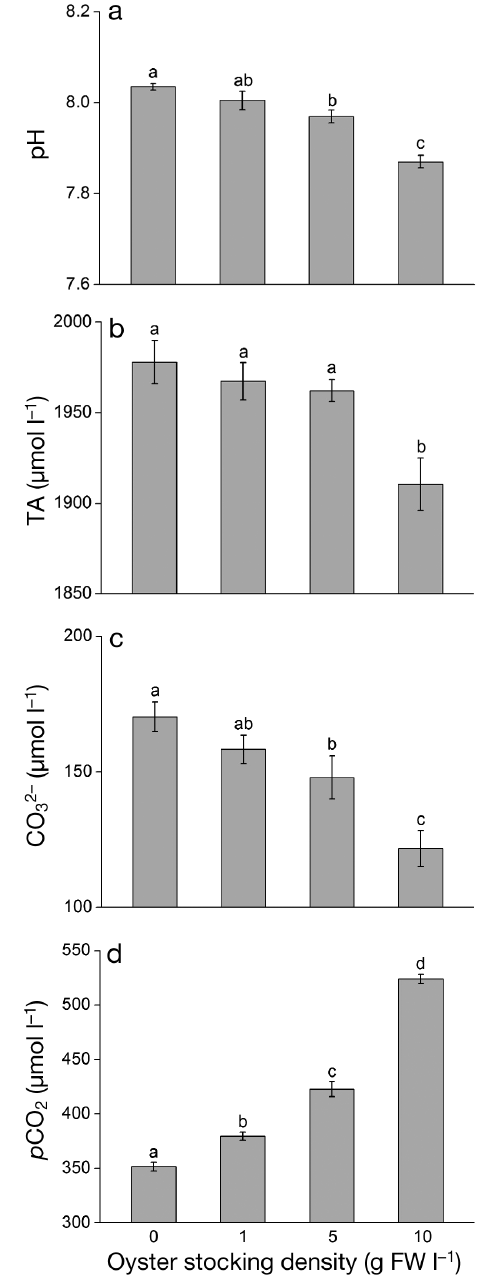
Fig. 2. Effects of Portuguese oyster Crassostrea angulata stocking density on (a) pH, (b) total alkalinity (TA), (c) CO 32− , and (d) p CO 2 of seawater in the closed mesocosm systems. Bars with different lowercase letters are significantly differ- ent (ANOVA, p < 0.05)